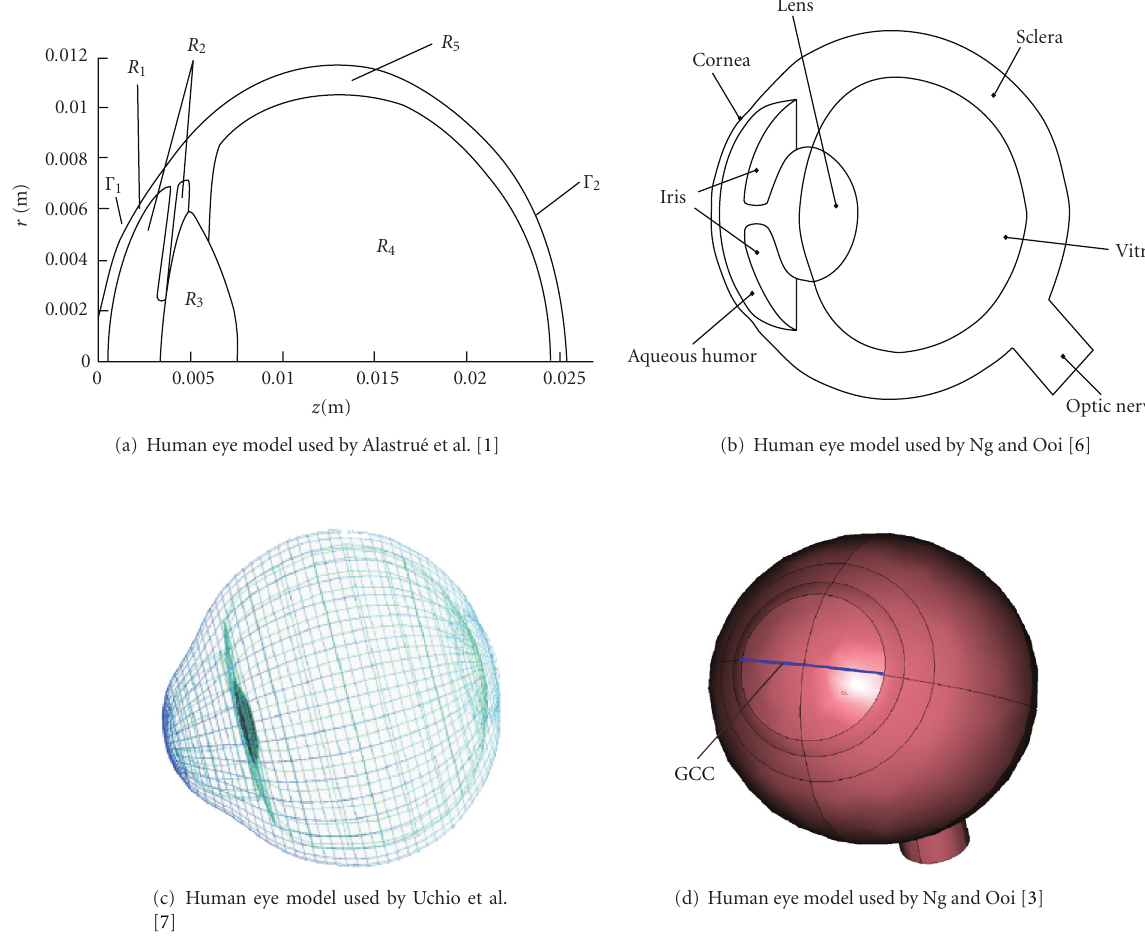
Figure 11: Human eye genomic models used in recent papers on computer simulation of biomechanical and biological heat transfer in